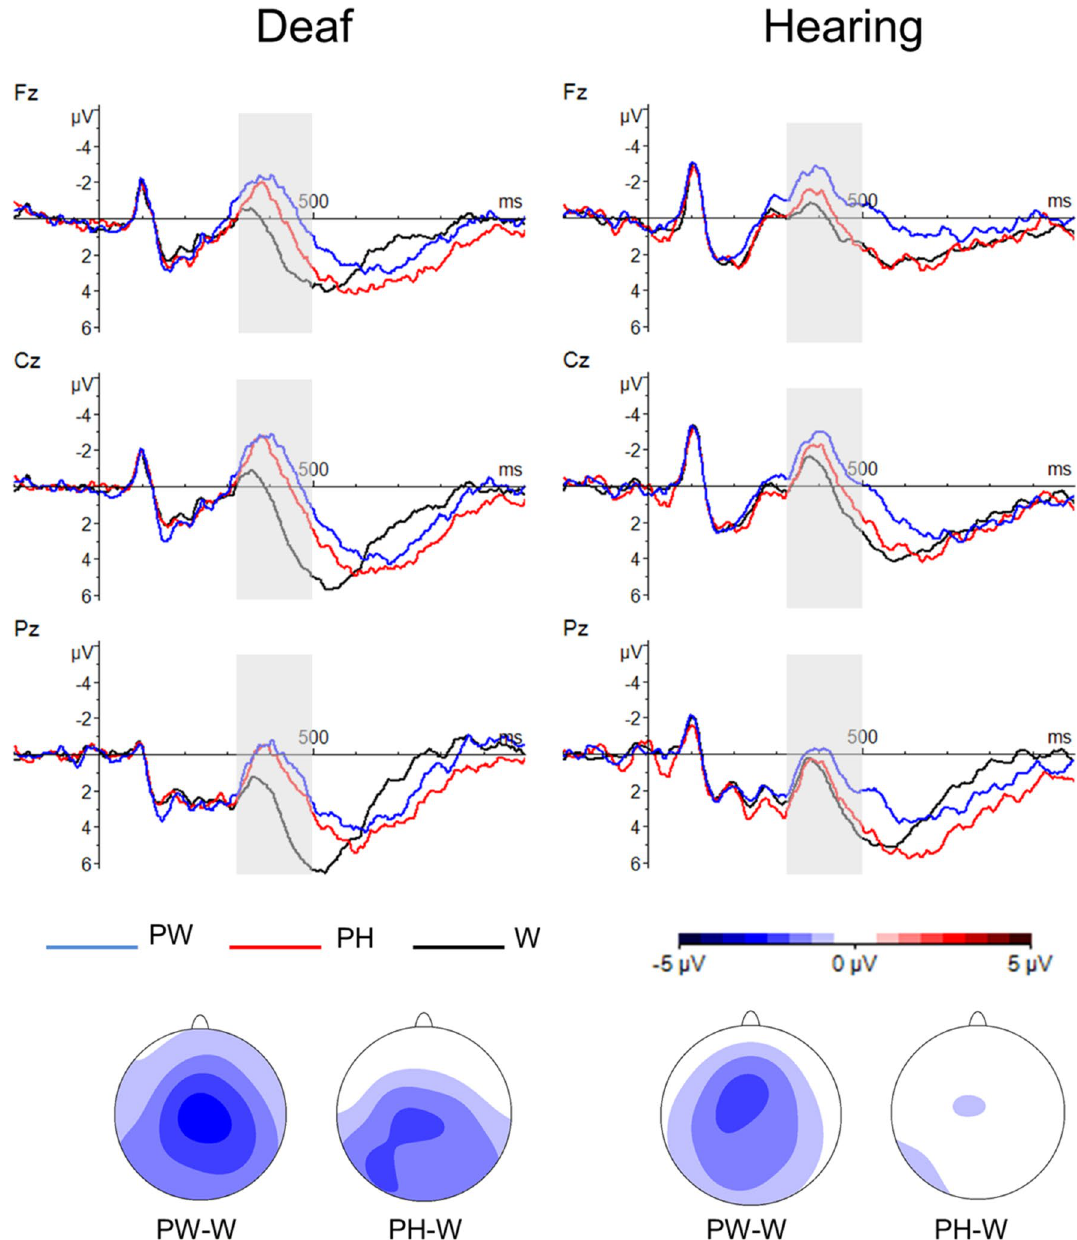
Figure 3. ERP results for Experiment 2 (lexical decision task). Top: grand average ERP waveforms for deaf (left) and hearing (right) groups. Midline electrodes (Fz, Cz, Pz) are displayed. Bottom: N400 topographical maps for 300–500 ms created by subtracting the average voltage of words from the average voltage of pseudowords, and the average voltage of words from the average voltage of pseudohomophones. PW Pseudowords, PH Pseudohomophones, W